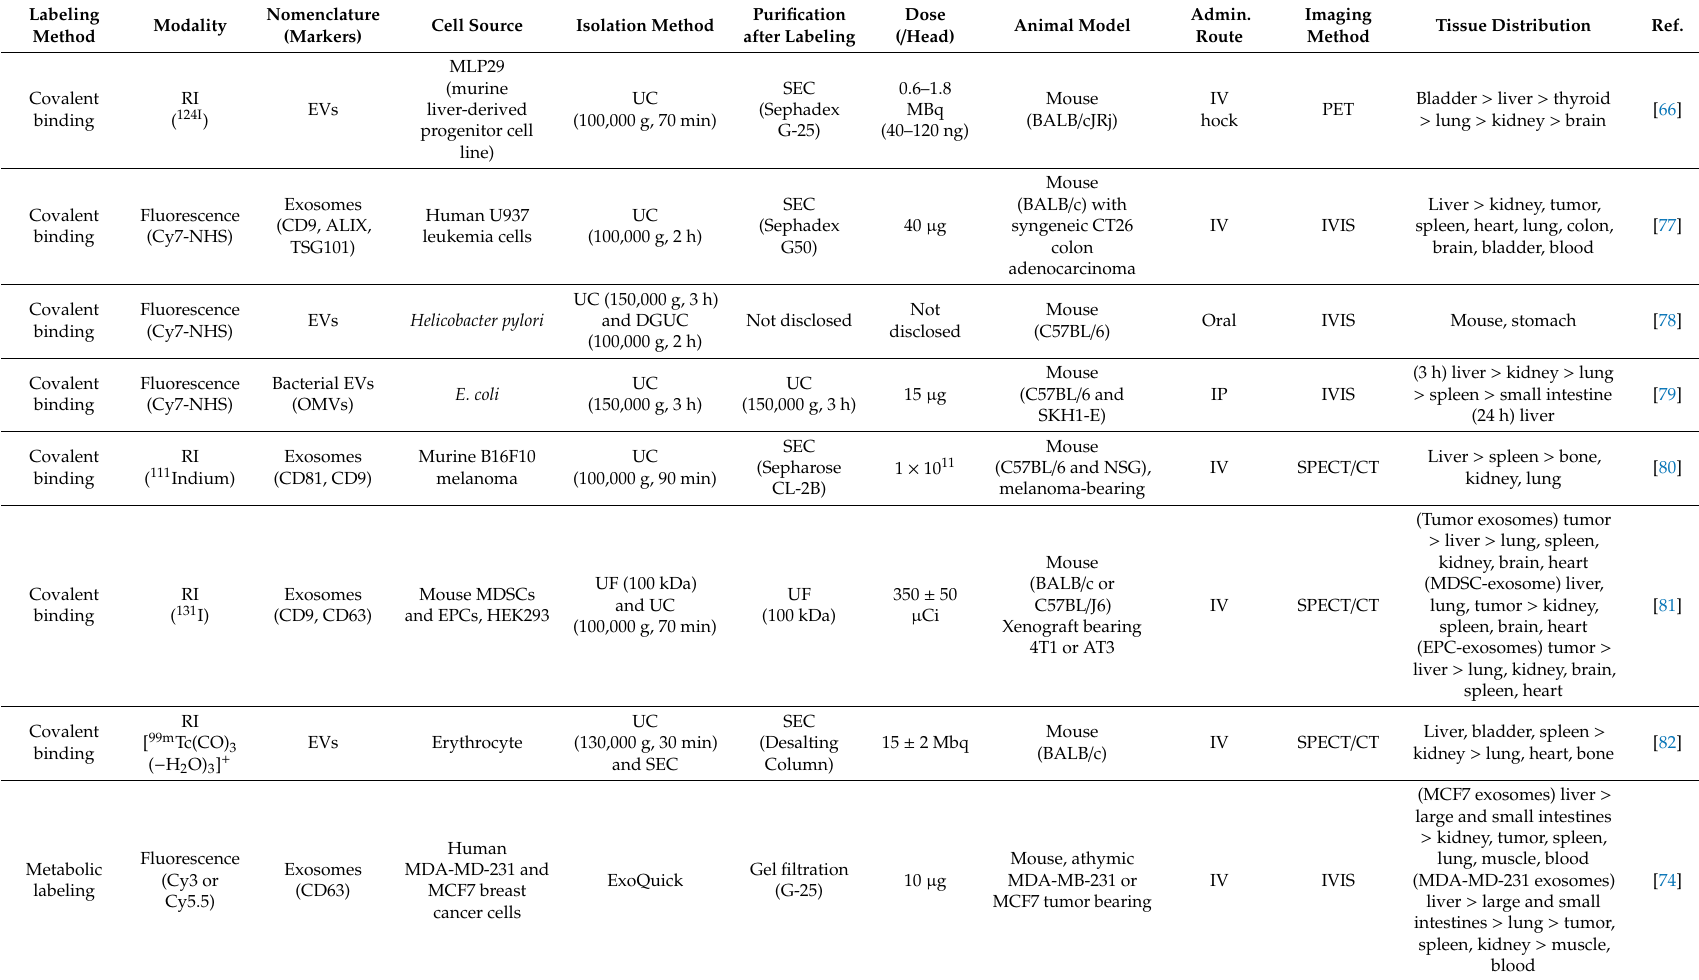
Table 4. Biodistribution of exosomes in